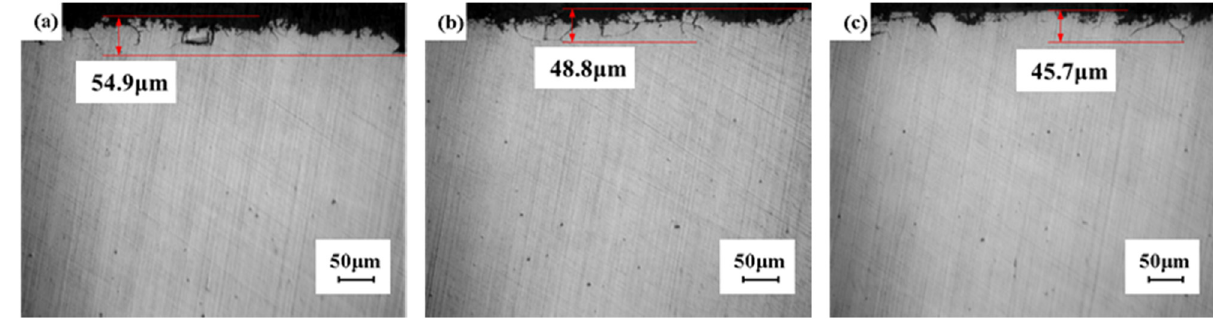
Figure 12: Intergranular corrosion morphologies of the AW joint: ( a ) BM, ( b ) HAZ, and ( c ) FZ.